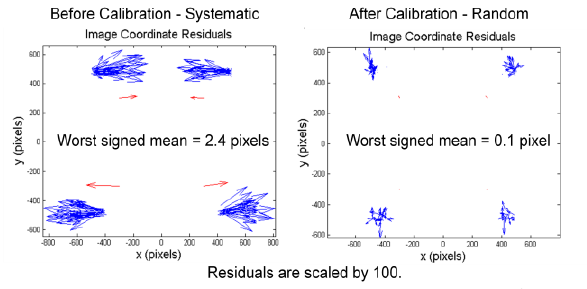
Figure 7. Image coordinate residuals at the 4 corners of each frame, before calibration (left) and after calibration (right) Section 7.2 provides a comparison of output images produced using a calibrated versus uncalibrated camera.